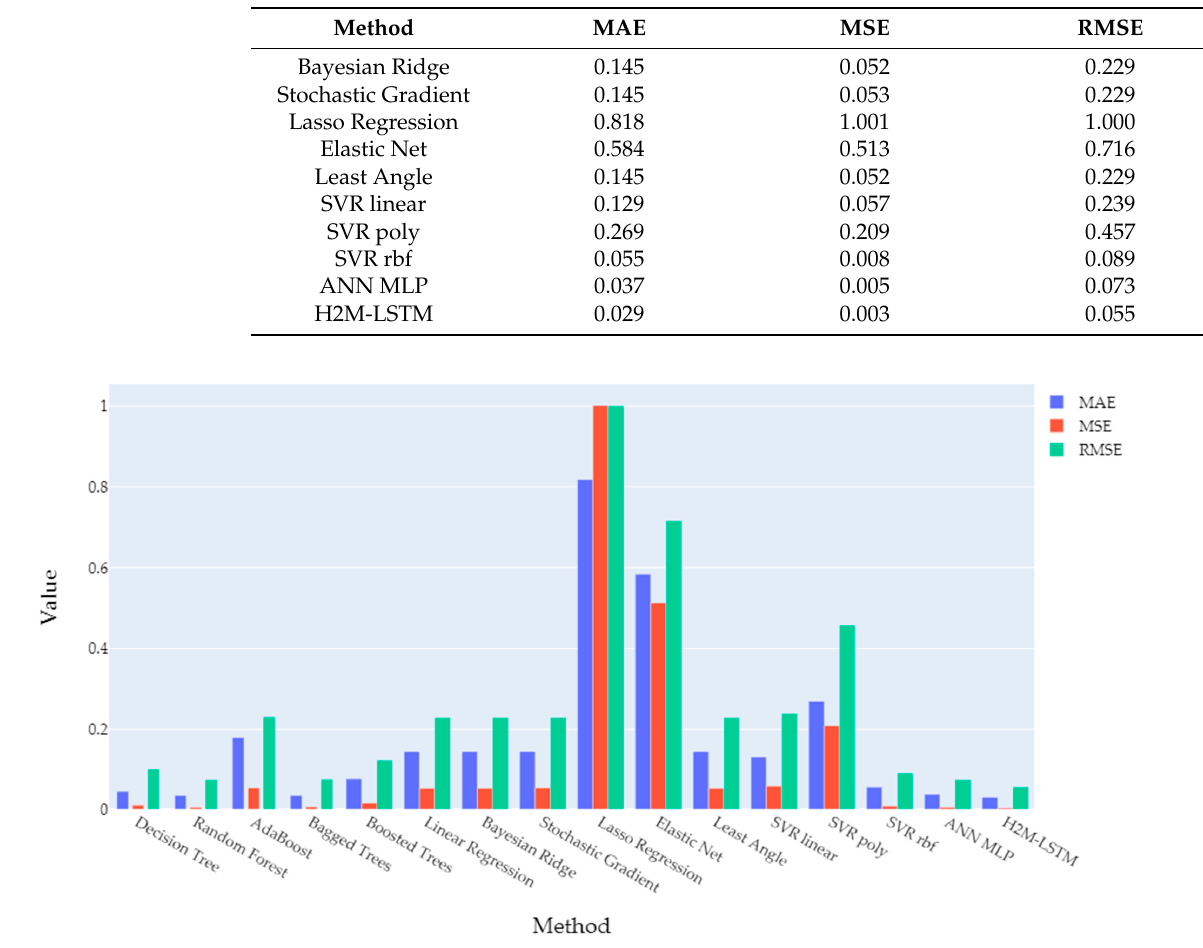
Table 5. Performance metrics for the machine learning algorithms used within the cascading archi- tecture.